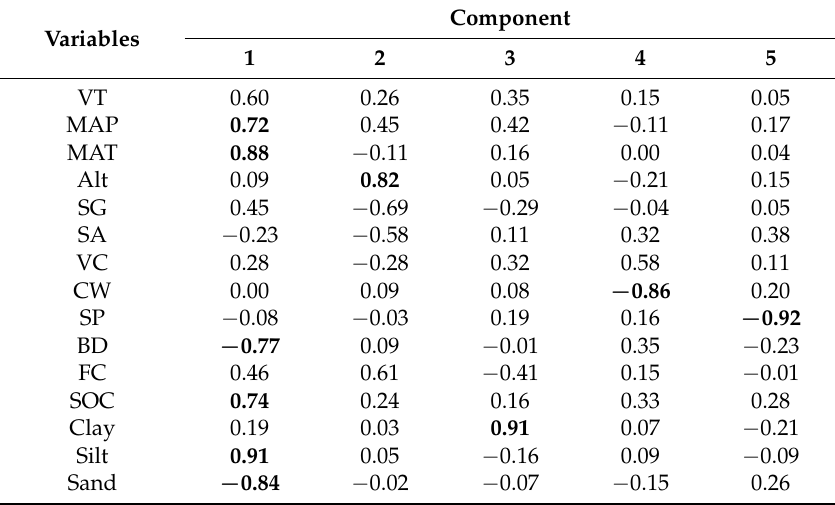
Table 3. Principal component analysis of the influencing factors after varimax rotation of the axes.